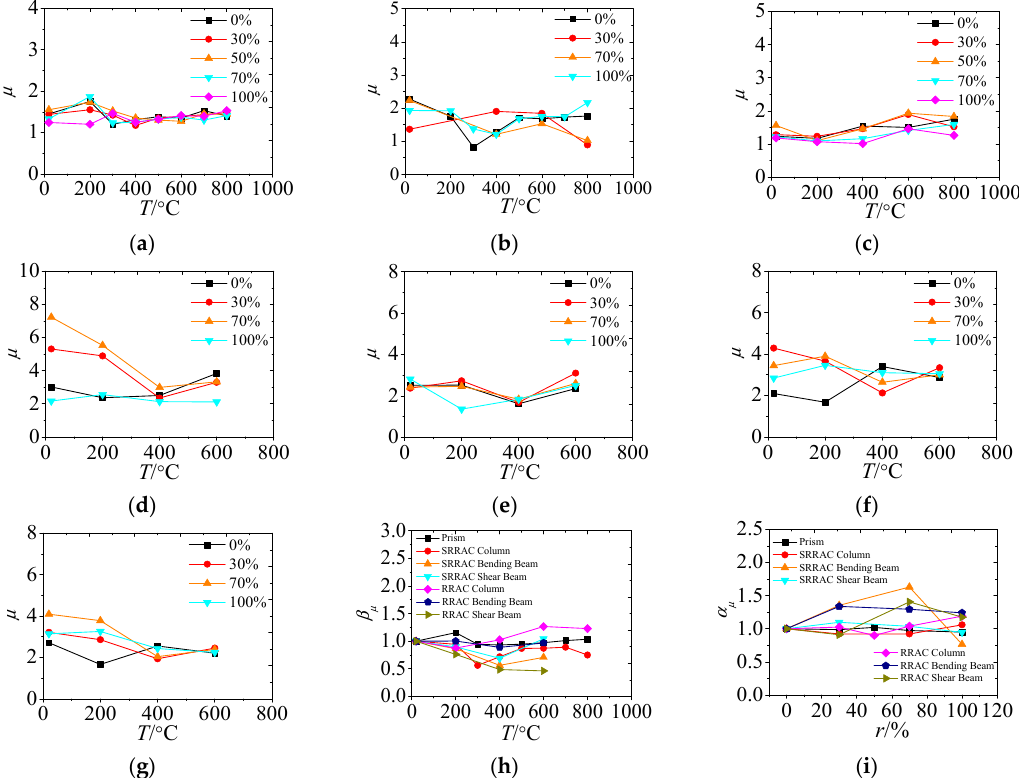
Figure 16. Influence of variation parameters on ductility. ( a ) Prism; ( b ) SRRAC column; ( c ) RRAC column; ( d ) SRRAC bending beam; ( e ) SRRAC shear beam; ( f ) RRAC bending beam; ( g ) RRAC shear beam; ( h ) Temperature; ( i ) Replacement percentage.